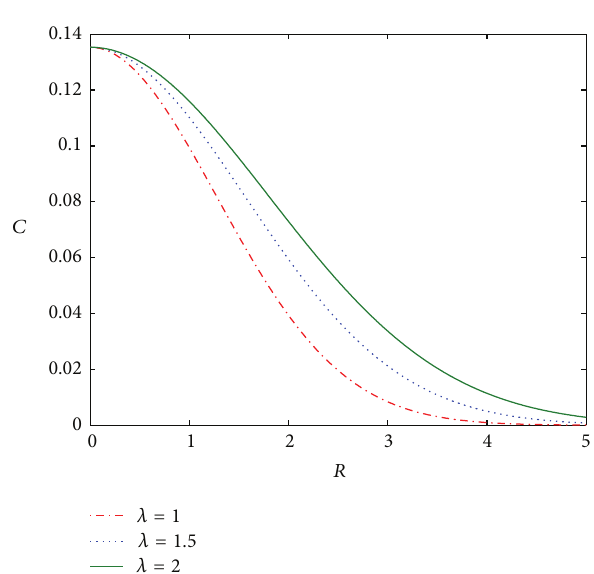
Figure 9: Effects of 𝜆 on the concentration profile for solution given in (39). Here 𝑅 = 𝑅 𝑎 = 2, 𝐶 0 = 1 , and 𝜏 = 2